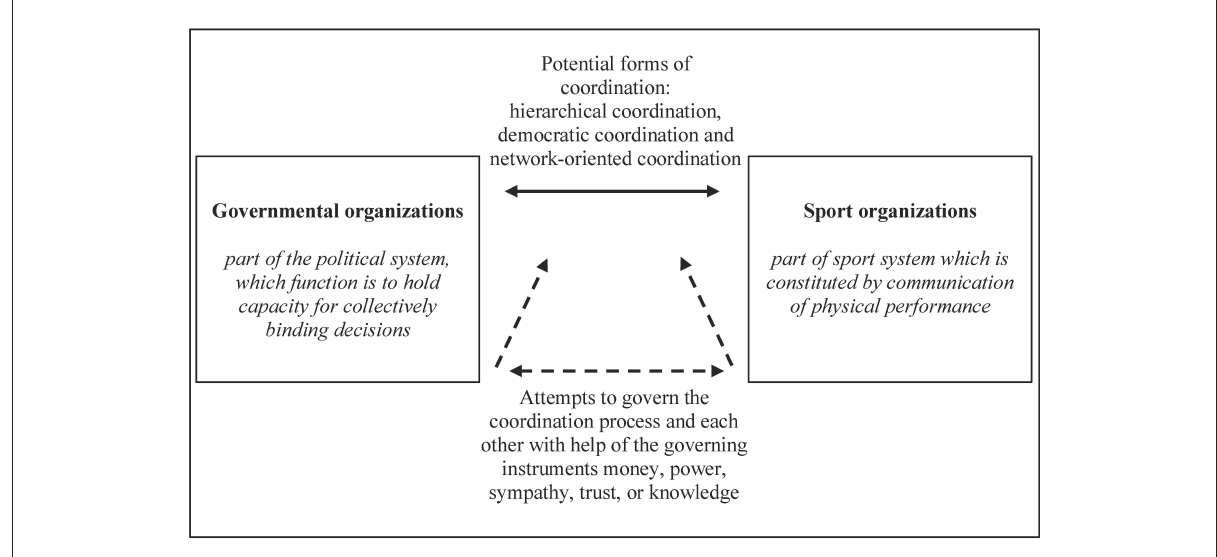
FIGURE1 Potential forms of the collaboration’s coordination and possible governing